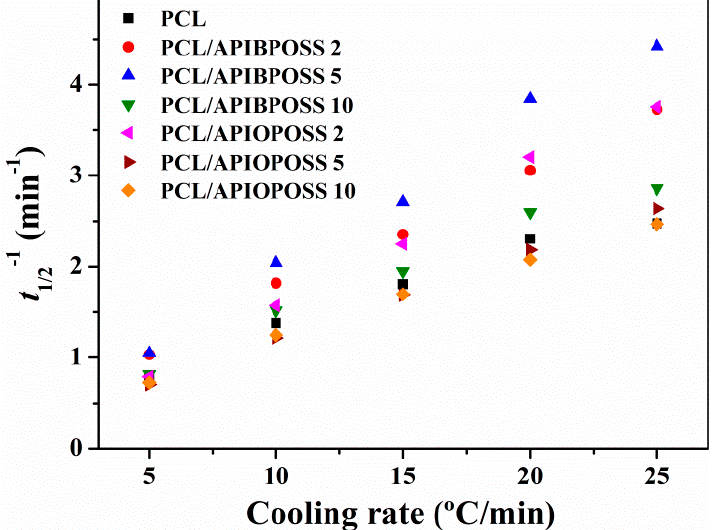
Figure 10. Reciprocal halftime of crystallization at different cooling rates for PCL and PCL/POSS nanocomposites.